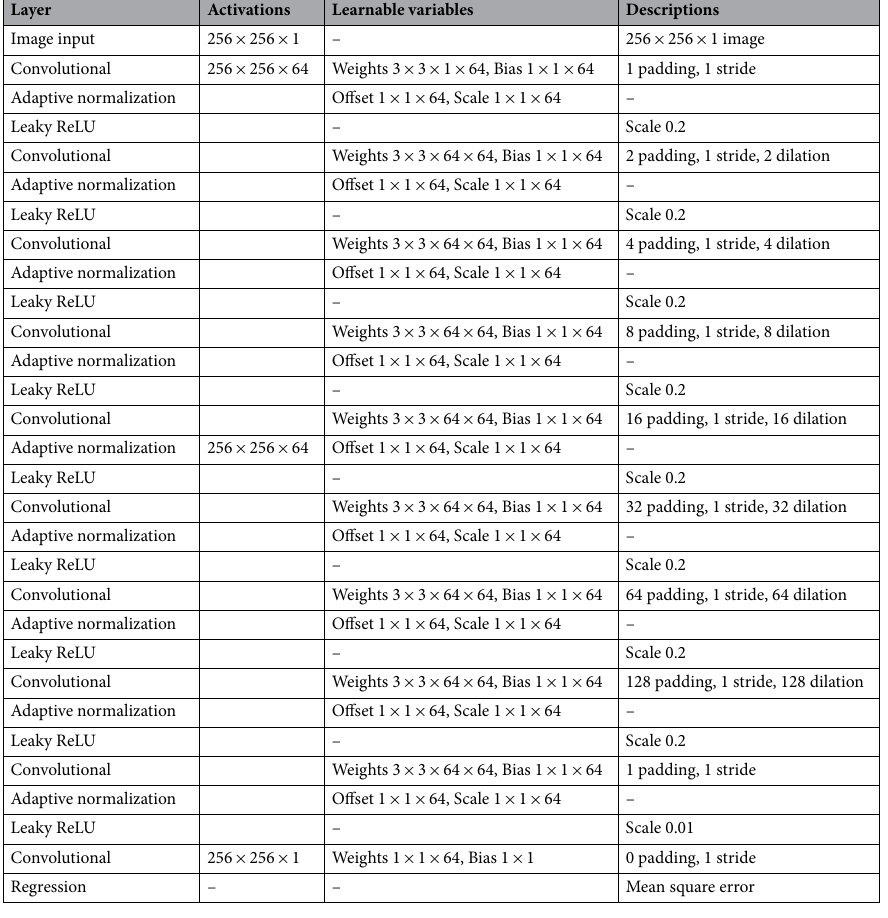
The CAN model is trained under the MATLAB2019c environment with a single GPU NVIDIA GeForce GTX 1050. The network was trained with a 0.0001 learning rate and a training iteration of 50 epochs. Simulated dataset for training, validation, and testing. Here, simulated data were employed to train the CAN network. It will be shown later that the trained network can be employed to analyze experi- mental data and provide the expected phase profile. The dataset simulation is based on Fresnel’s equation 31 and the transfer matrix approach 31,45 , calculating the reflection and transmission coefficients (Fig. S1). Materials’ parameters, including the gold refractive index (n m ) and the thickness (d m ), the sample refractive index (n s ), were varied to generalize the SPR phenomenon for network training accommodating for errors and discrepan- cies in experimental measurements. The parameters consist of random gold film thickness in a range of 20 to 60 nm (Fig. S2), random incident wavelength in a range of 550 to 650 nm, the refractive index of the gold 46 n m of 0.18 + 3.44i with ± 10% error in real part and imaginary part, and random refractive index of the sample n s in a range of 1.0 to 1.4 as labeled in Fig. 2. The simulated BFP was cropped to only one quadrant (256 × 256 pixels), as shown in Fig. 4. All four quadrants carry redundant information due to symmetry in the BFP of the uniform sample. There were 1000 input and output image pairs in each dataset for training and validation. The dataset was further separated to 90% and 10% ratio for training and validation, respectively. The dataset consists of 2 types of simulated images, including the BFP image input data and the correspond- ing phase output of the BFP. The phase profiles of the BFP were employed as the label for supervised learning. The dataset preparation process is shown in Fig. 5. Firstly, the amplitude of BFP and phase of BFP were com- puted using the Fresnel equations and the transfer matrix approach. These images were then read during CAN network training and validation. For testing the networks, the gold thicknesses of 30 nm, 40 nm, 45 nm, and 50 nm, the incident wavelength of 633 nm, and the sample refractive index range from 1.00 (air) to 1.372 (liquid BSA-protein 11 ) were excluded from the dataset for training and validation to test the performance of the trained network. Monte Carlo based shot noise model. To estimate the phase noise of the BPF phase profile recovered from the DL-based method, the number of photons with associated shot noise in each camera pixel. The other